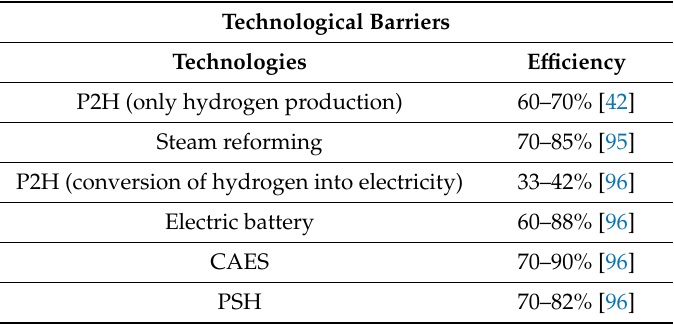
Table 3. Technological barriers. Technologies’ performances.